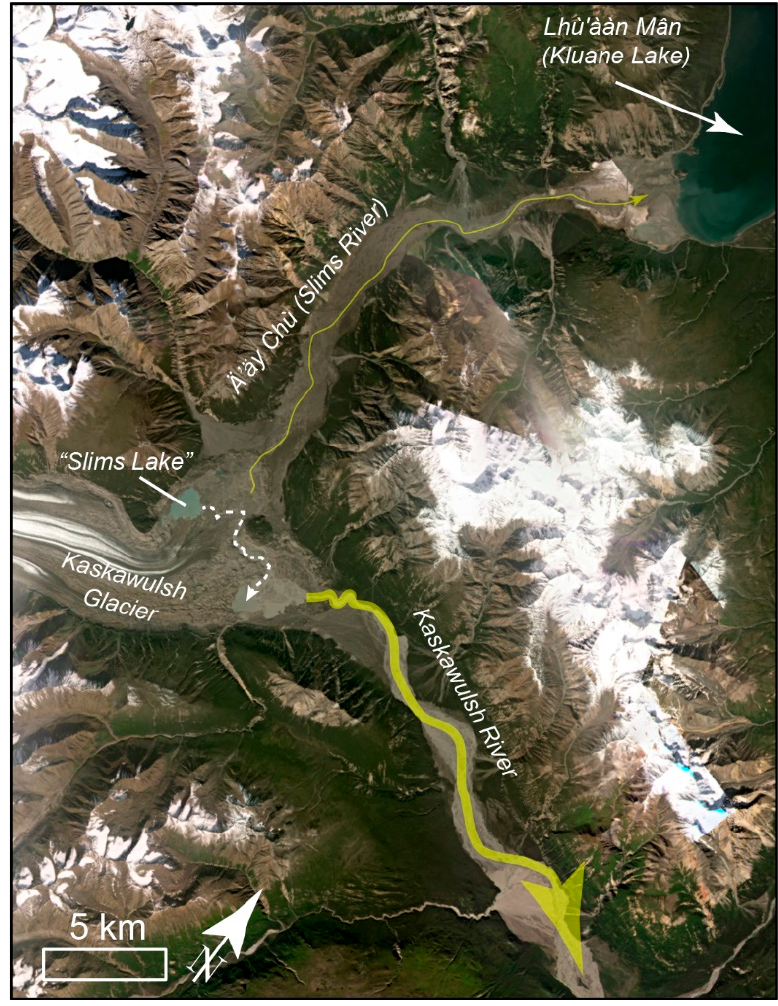
Figure 2. Satellite image showing drainage change at the terminus of Kaskawulsh Glacier between 2015 and 2016. The thin yellow arrow indicates the main meltwater discharge route prior to piracy. The path of Kaskawalsh River, which captured Ä’äy Chú, is indicated by the thick yellow arrow. Background image is an August 2021 satellite mosaic from Planet, and projection is Canada Albers Equal Area Conic.